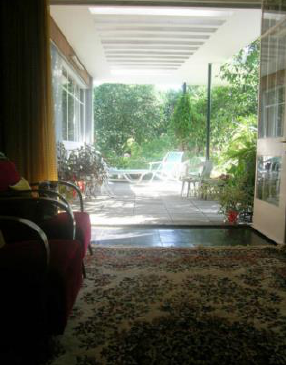
Figure 20. Relation between inside and outside.